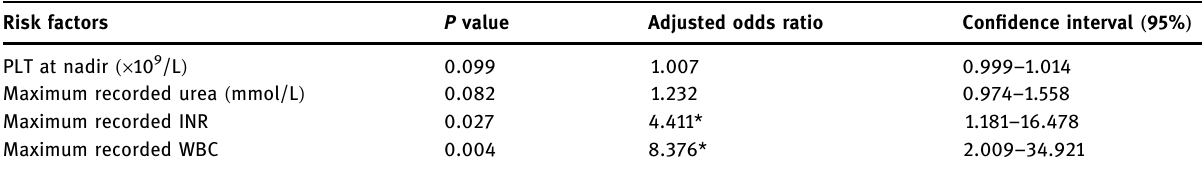
Table 3: Multivariate analysis of factors associated with CVS Risk factors P value Adjusted odds ratio Con fi dence interval ( 95%